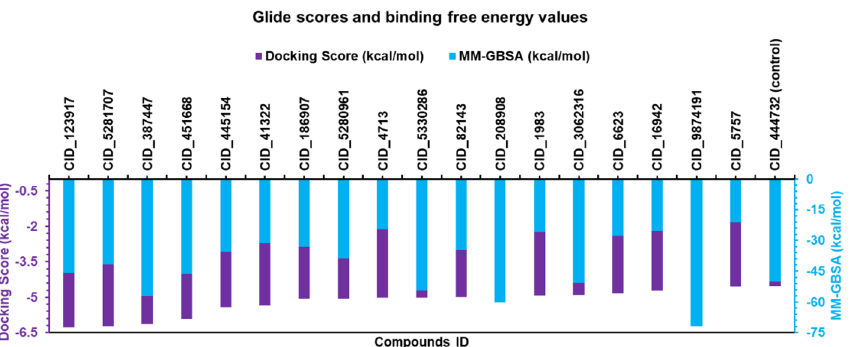
Figure 2. Bar graph representing the docking score and binding free energy values of the 18 hit compounds along with the control compound